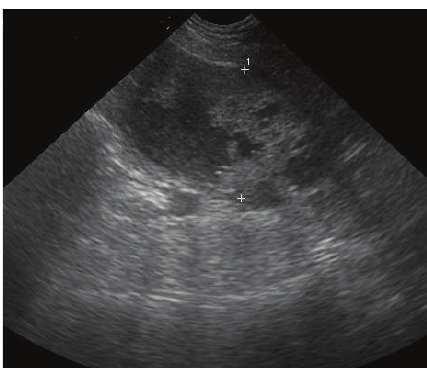
Figure 1: Sagittal ultrasound image of the prostate gland taken on initial presentation. Note the marked prostatomegaly with large cavitary areas containing hyperechogenic fluid within the gland.